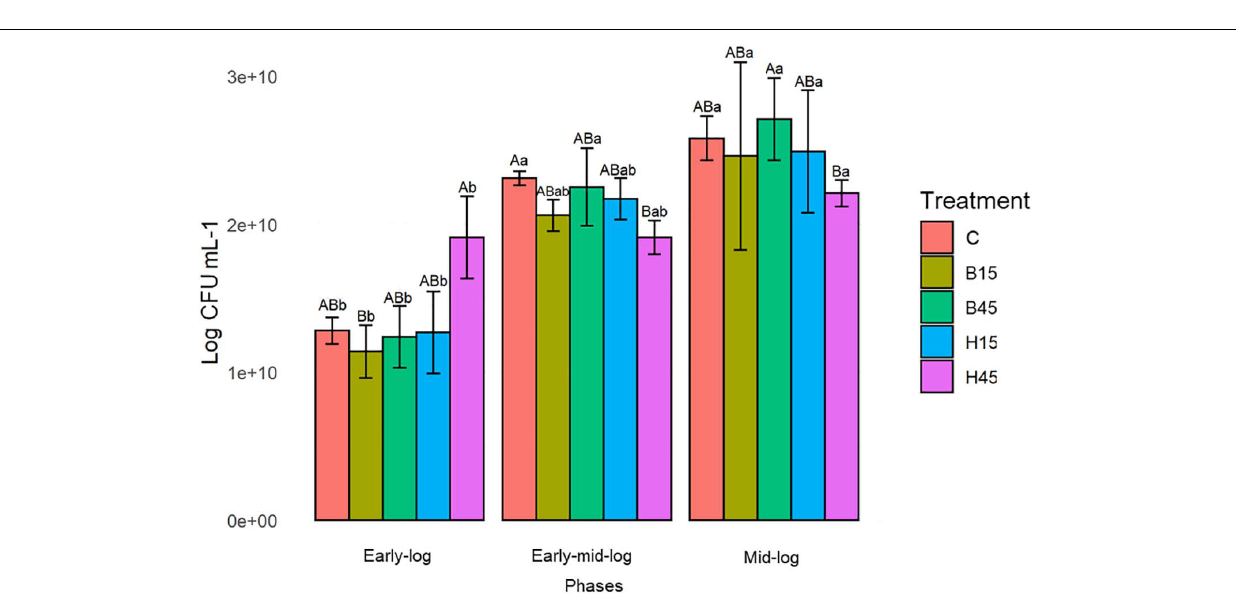
FIGURE 3 | Cell viability of Pseudomonas sp. CMA 6.9 in control treatments (C) and with the herbicides Boral R (cid:13) (B15 and B45) and Heat R (cid:13) (H15 and H45) in the three growth phases indicated. Data were obtained in triplicate for each treatment and statistically analyzed using a randomized complete block design using the Duncan test ( p < 0.05). Error bars represent standard errors of the means. Different uppercase letters represent statistically significant differences between treatments at the same time; lower-case letters represent statistically significant differences between treatments at different